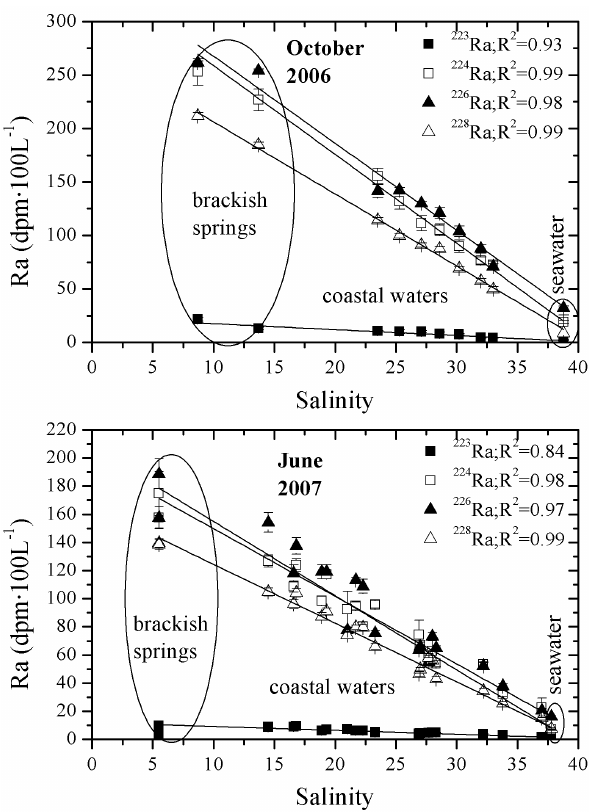
Fig. 6. Radium activities plotted against dissolved inorganic silica (DSi). Positive linear correlations are observed for all isotopes in October 2006 and June 2007, pointing to a conservative behavior of DSi once released from coastal brackish